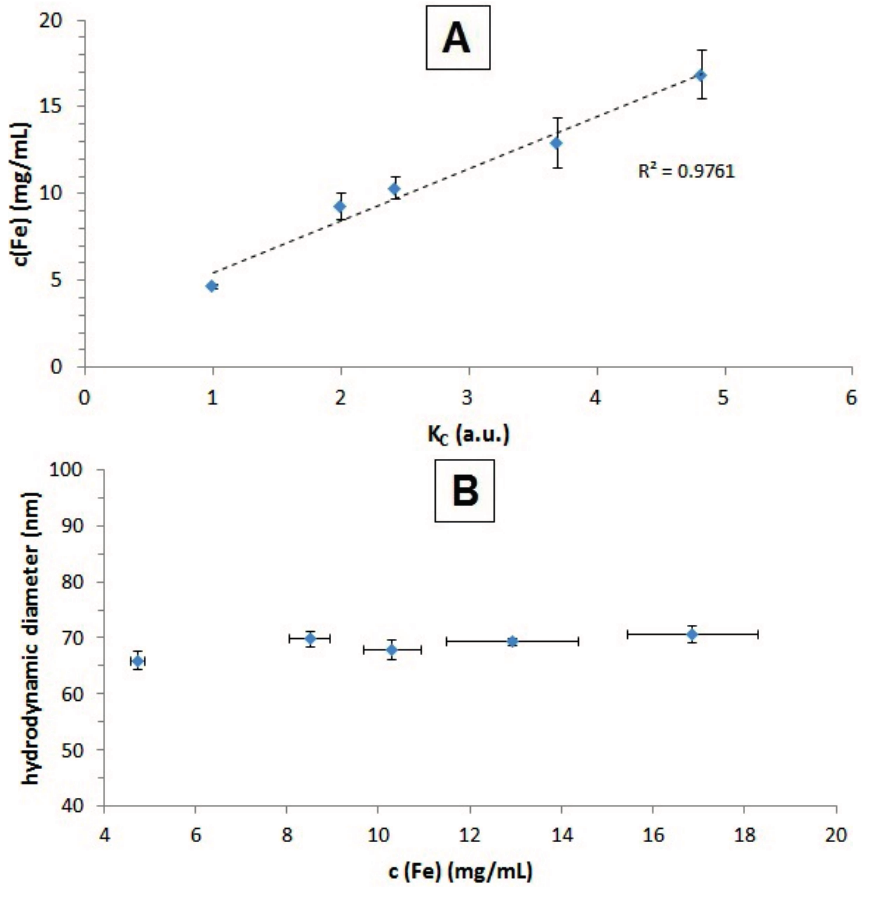
Figure 4. Efficiency of the concentration and the effect on the hydrodynamic aggregate size of SEON LA-BSA . The iron content of SEON LA-BSA ( A ) depending on the ratio of the starting volume/end volume (concentration factor); ( B ) PCCS measurements of the hydrodynamic diameters of the samples from ( A ). All measurements for ( A , B ) were performed in